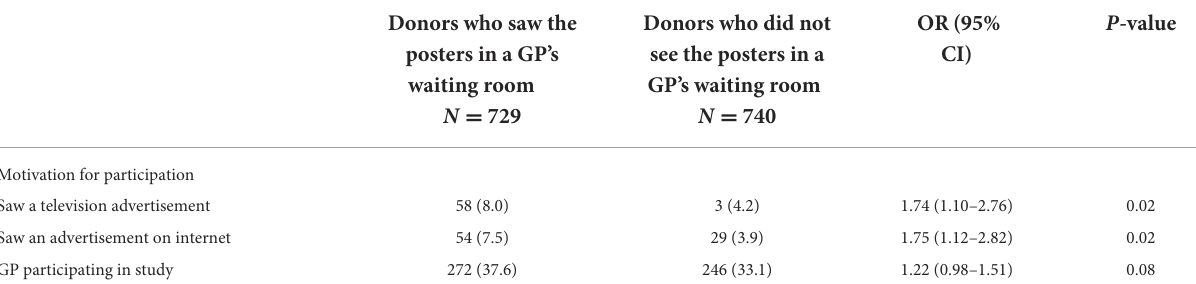
TABLE 5 Factors motivating participation in the blood